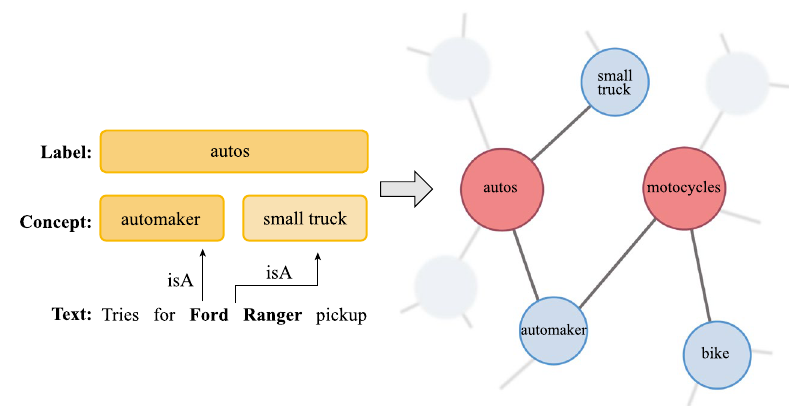
Fig. 1 A case study of the label–concept relationship graph shows the example’s instance, concepts, and the label on the left and the correspond- ing labels, concepts, and their relationships on the